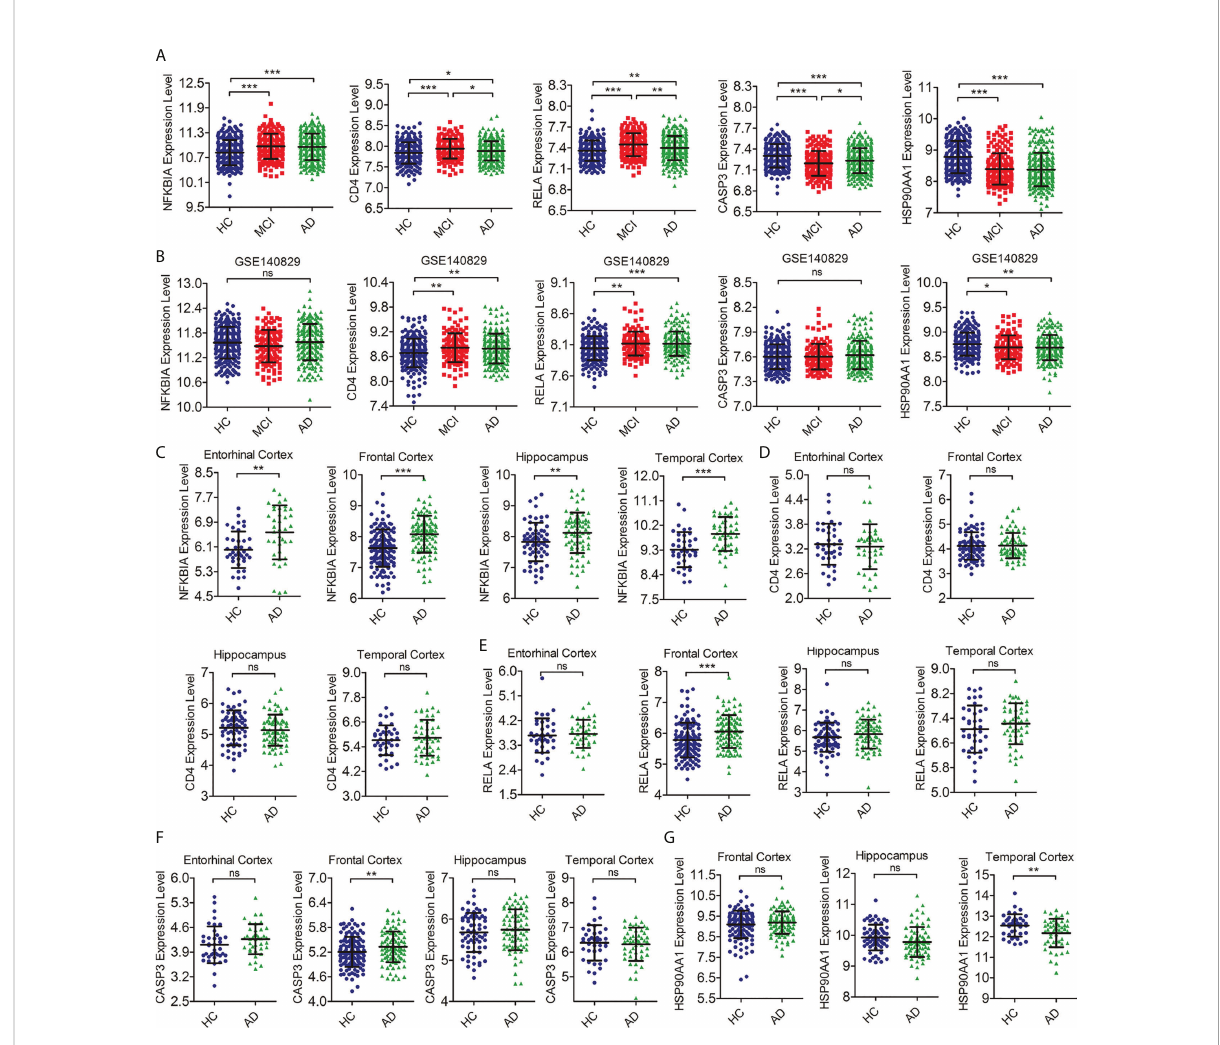
FIGURE 5 Veri fi cation of the expression level of hub IRDEGs. (A) The scatter plot showed the difference in expression levels of fi ve hub IRDEGs in the peripheral blood of HC, MCI, and AD patients from the GSE63060 and GSE63061 datasets. (B) The scatter plot showed the difference in expression levels of fi ve hub IRDEGs in the peripheral blood of HC, MCI, and AD patients from the GSE140829 datasets. (C – G) The expression level of fi ve hub IRDEGs in four brain regions (entorhinal cortex, hippocampus, temporal cortex, and frontal cortex) of HC and AD groups were analyzed from the Alzdata database. The data were presented as mean ± SEM. The difference among the three groups was analyzed through a one-way analysis of variance (ANOVA) and followed by Fisher ’ s least signi fi cant difference (LSD) test. The difference analysis between the two groups was completed by a two-tailed Student ’ s t -test. * p < 0.05; ** p < 0.01; *** p < 0.001; ns, no statistical difference; IRDEGs, immune-related different expression genes; HC, healthy control; MCI, mild cognitive impairment; AD, Alzheimer ’ s